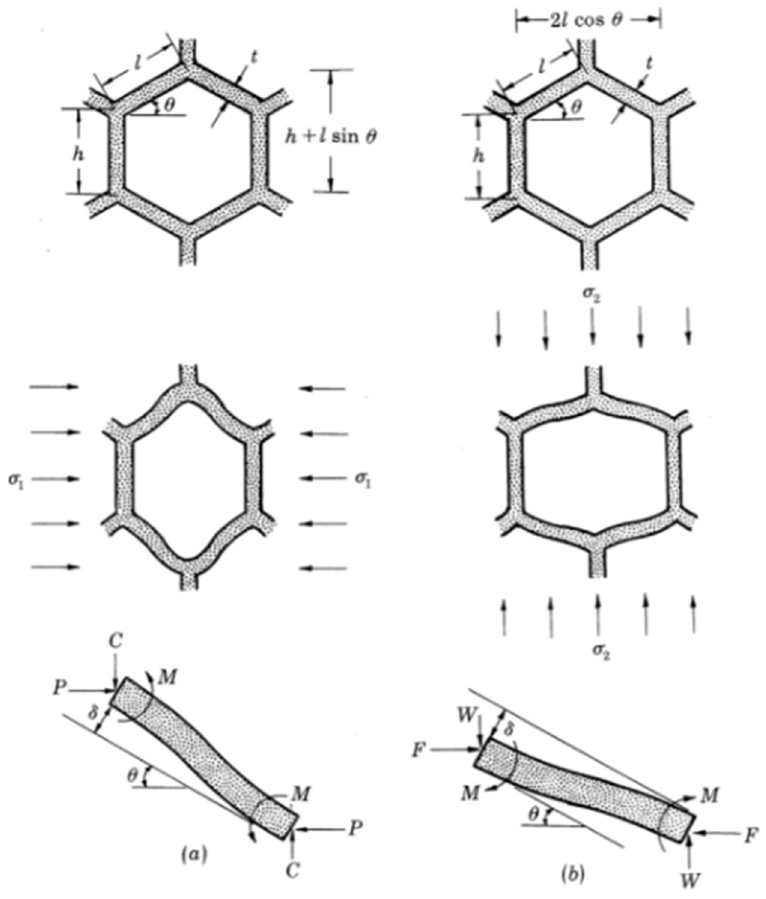
Figure 3. Beam theory application on honeycombs [4].